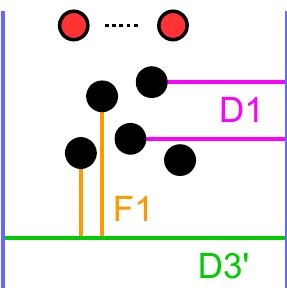
, with two D1s ema- 2 ; 2